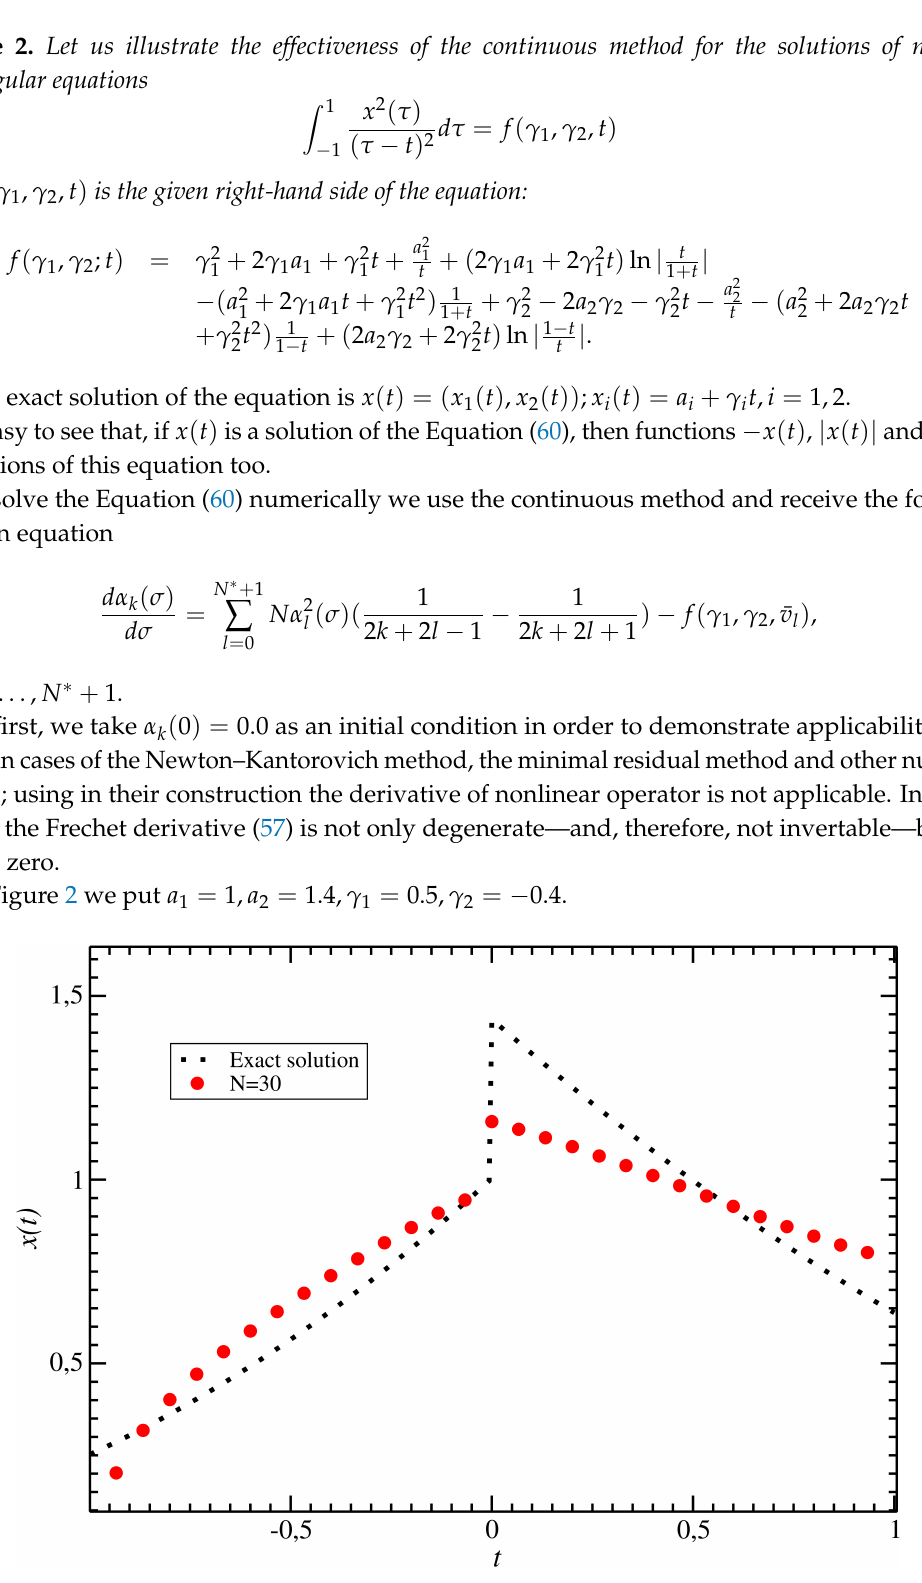
Figure 2. Numerical solution for the nonlinear hypersingular equation with a discontinuous right-hand side